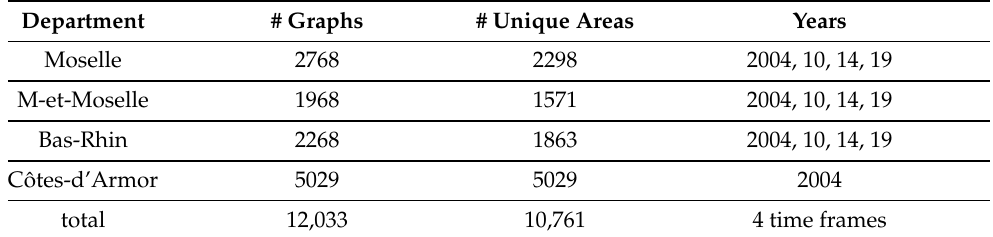
Figure 8. ( Left ): Superimposed graphs OSM 2020 (blue) and IGN 2004 (orange). ( Right ): superim- posed graphs OSM 2020 and IGN 2019. Same geographical area across years and sources. Table 1. The characteristics of the proposed dataset for cross-time geographic area retrieval. Note that we mostly deal with single geographic area correspondence across years.